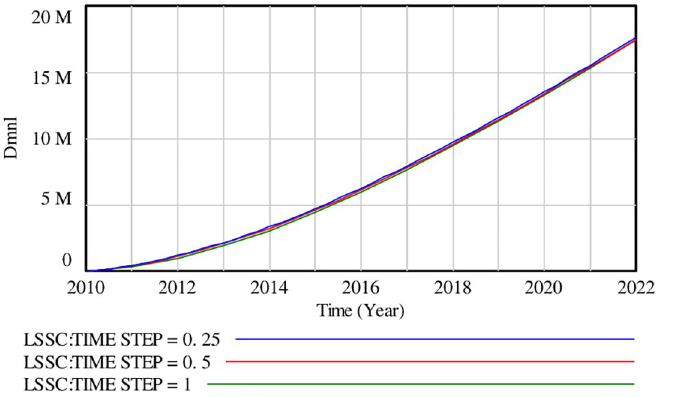
Fig 4. Changes in the stability of model triggered by the TIME STEP.